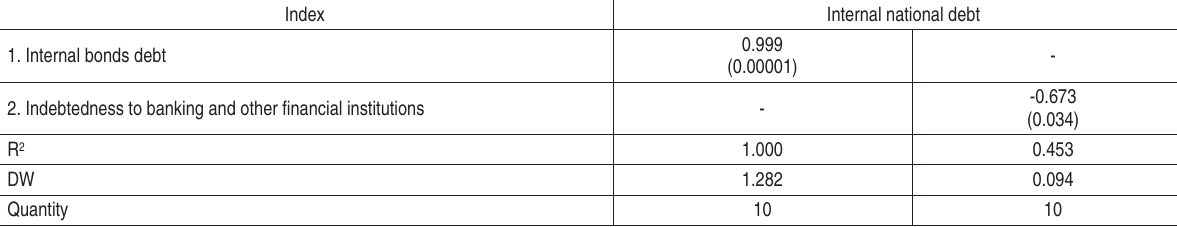
Table 5. The factors of correlation analysis of internal national debt dynamics for the 2006-2015